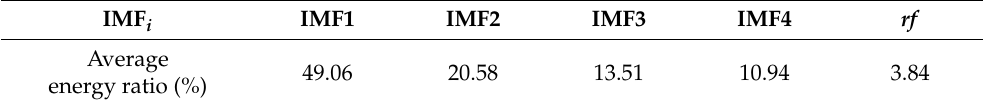
Table 1. Average energy ratio of intrinsic mode function IMF1/2/3/4/RF (59 samples with 4*IMF +